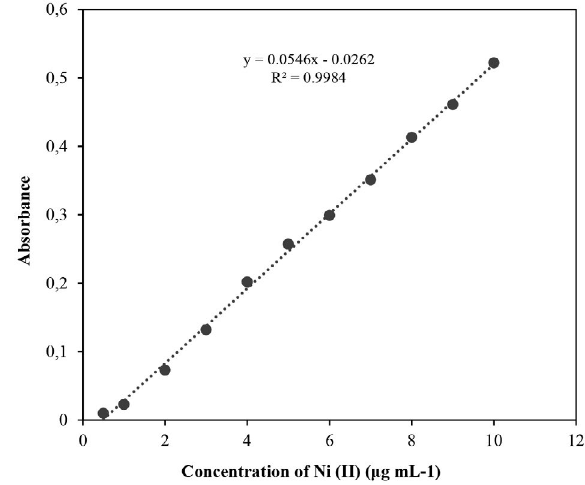
Figure 3. Ni (II) nanoparticles adsorption